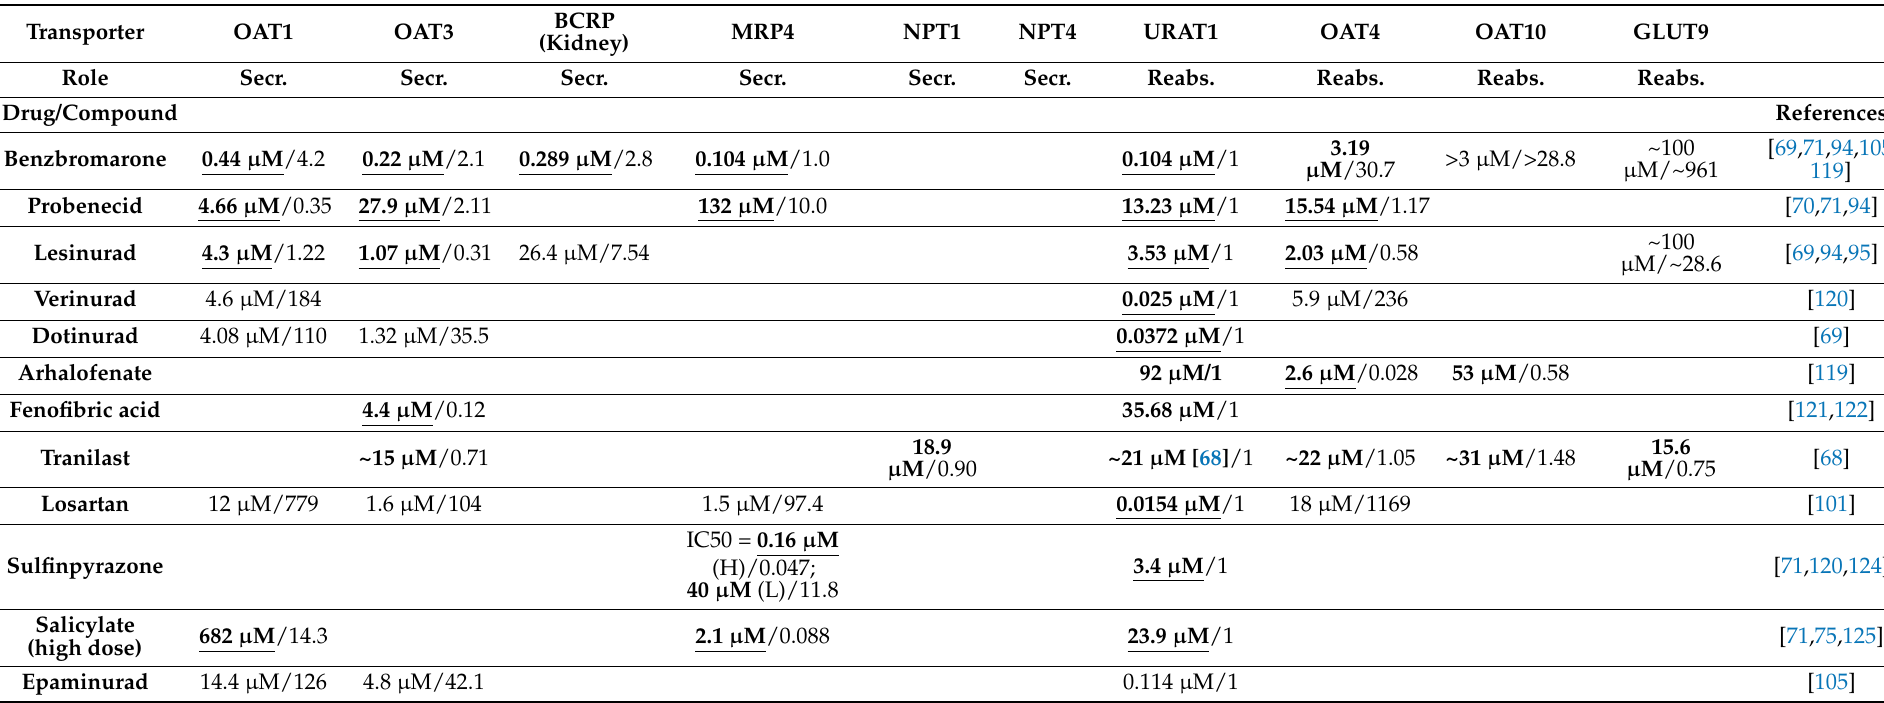
Table 4. Relative inhibition potencies. The IC50 of each drug for a given transporter is compared with its IC50 for URAT1. For this calculation, the estimate IC50 = 2 × Ki was used when the IC50 was not available or 2 × Ki was lower than the available IC50. Values shown for each transporter are IC50 transporter followed by the ratio IC50 transporter /IC50 URAT1 ). Relative inhibition values >1 indicate weaker inhibition, values <1 indicate stronger inhibition compared to URAT1. The rules for highlighting in bold or bold and underlined are the same as in Table 3. Abbreviations: Secr., secretion; Reabs.,